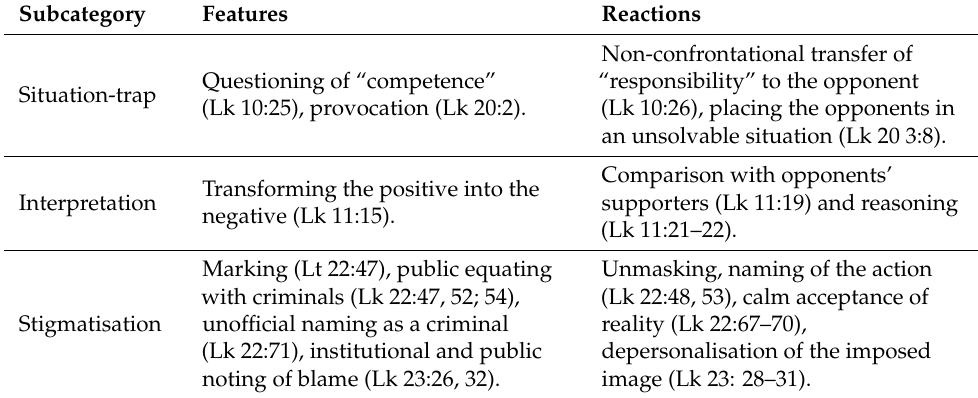
Table 3. Features of